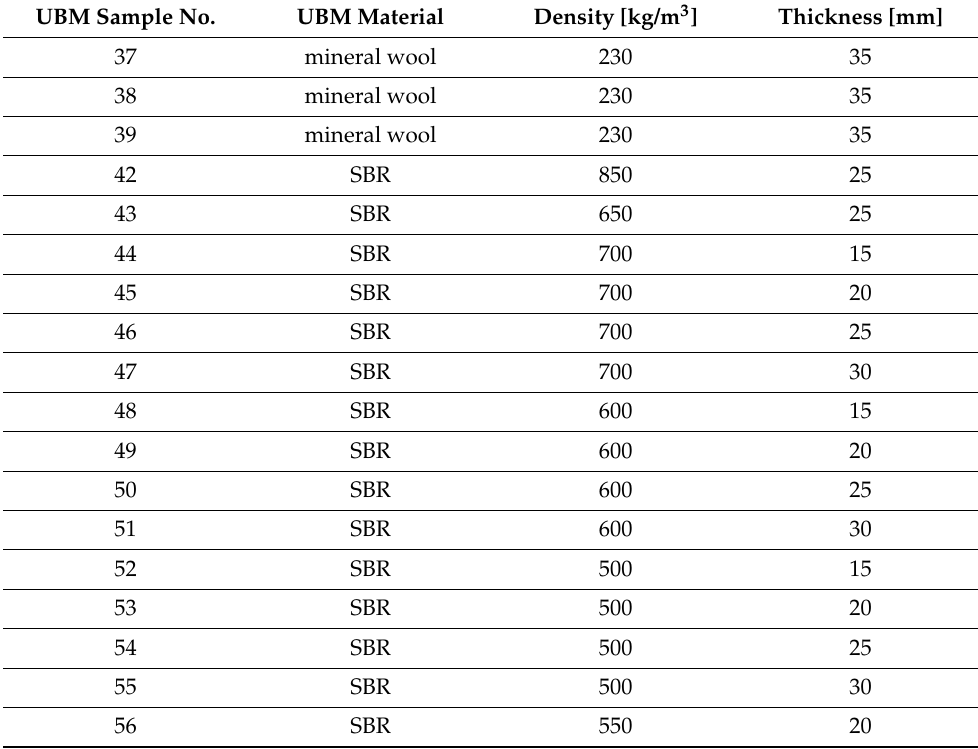
Table 6. Properties of tested UBM samples. UBM Sample No.